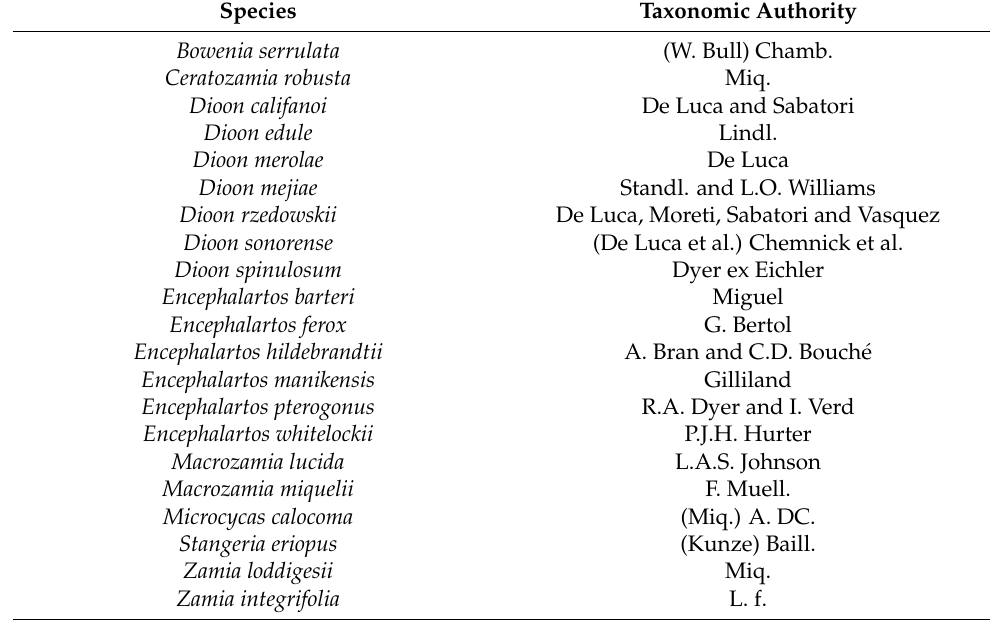
Table 2. List of Zamiaceae species that are reported as hosts for Aulacaspis yasumatsui . The list is developed from the literature and from the authors’ personal observations. Species Taxonomic Authority Bowenia serrulata (W. Bull)